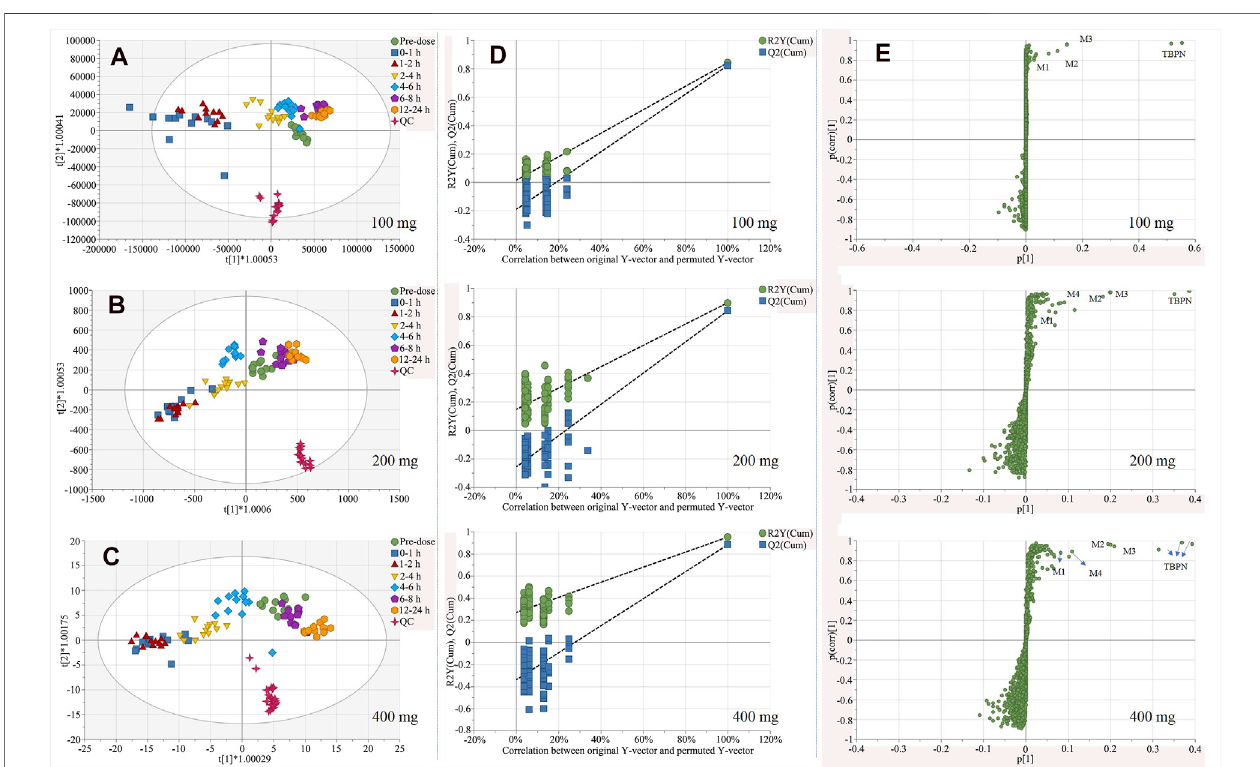
FIGURE 3 | OPLS-DA score plot for urine samples of pre-dosedose, 0 – 1, 1 – 2, 2 – 4, 4 – 6, 6 – 8, and 12 – 24 h after oral administration of 100 mg (A) , 200 mg (B) , 400 mg (C) ofTBPM-PI,andcorrespondingpermutationtests (D) ,aswellasS-plots (E) of0 – 1 hvs. per-dose urinesamplesinthreedosegroup( n (cid:2) 12foreach dose). Note: t (1) and t (2) indicate the fi rstand thesecond components inthe OPLS-DA model; R 2 Y (cum) means cumulative R 2 Yfor the extracted components; Q 2 (cum) was cumulative Q 2 for the extracted components; p (1) indicates the importance of the variables in approximating X in the fi rst component. p (corr) (1) shows the correlation coef fi cient of p (1) between X and t